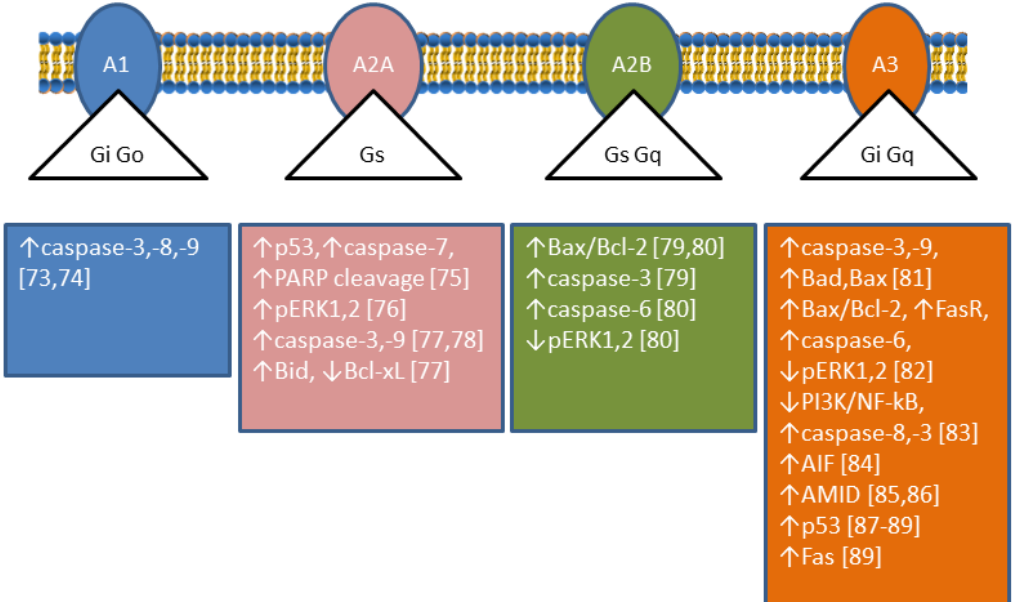
Figure 3. Effectors of adenosine receptor-mediated apoptosis. The figure shows the different types of G-proteins associated with the four adenosine receptors and illustrates the apoptosis effectors found in several models by using agonists and antagonists of the receptors, or receptor silencing. The numbers in brackets refer to the respective reference. Note that adenosine receptors can be involved in survival in other cell types [71].